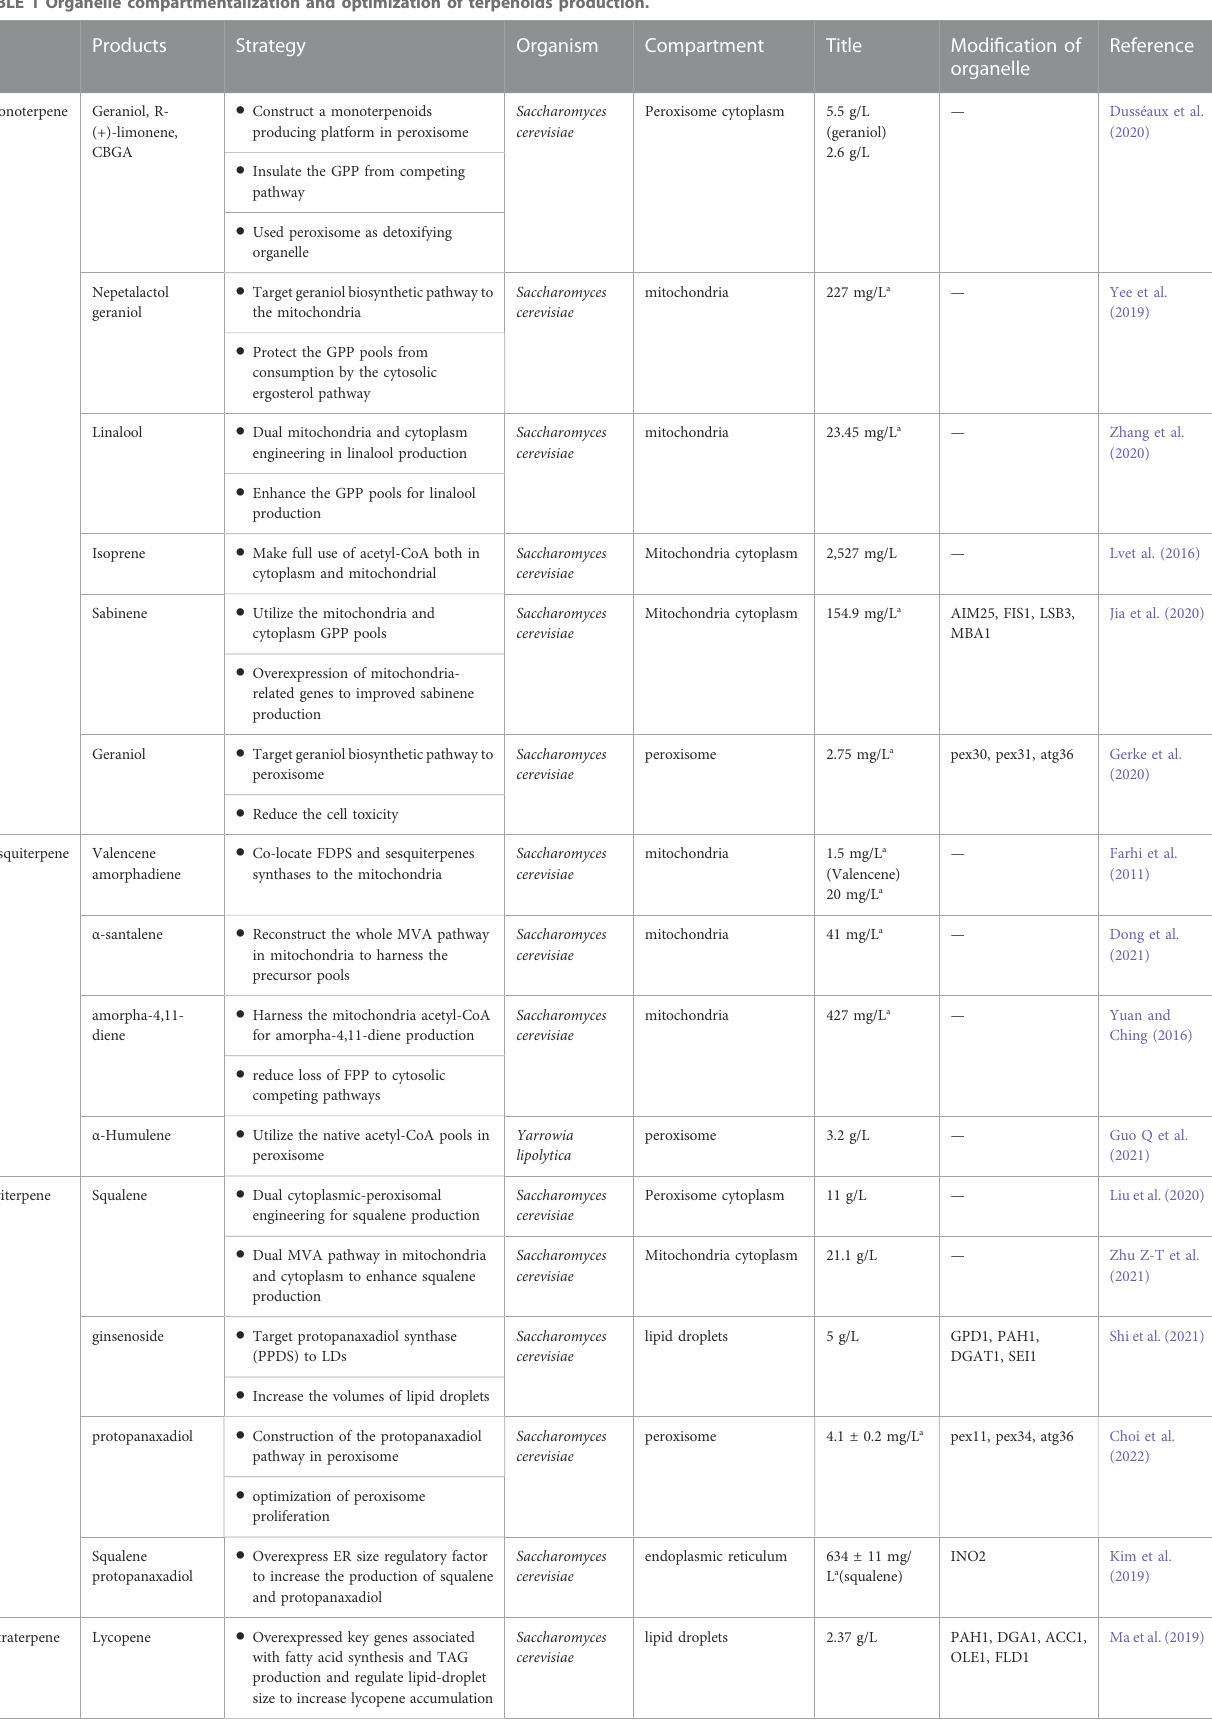
TABLE 1 Organelle compartmentalization and optimization of terpenoids production.